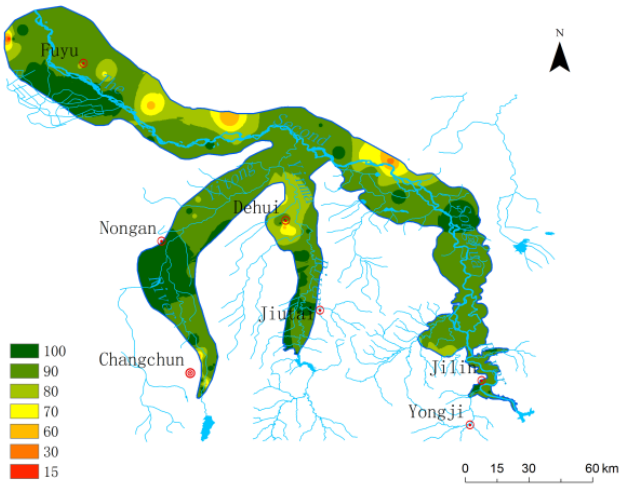
Figure A9. Distribution of the groundwater depth scores influence zone width of surface water.